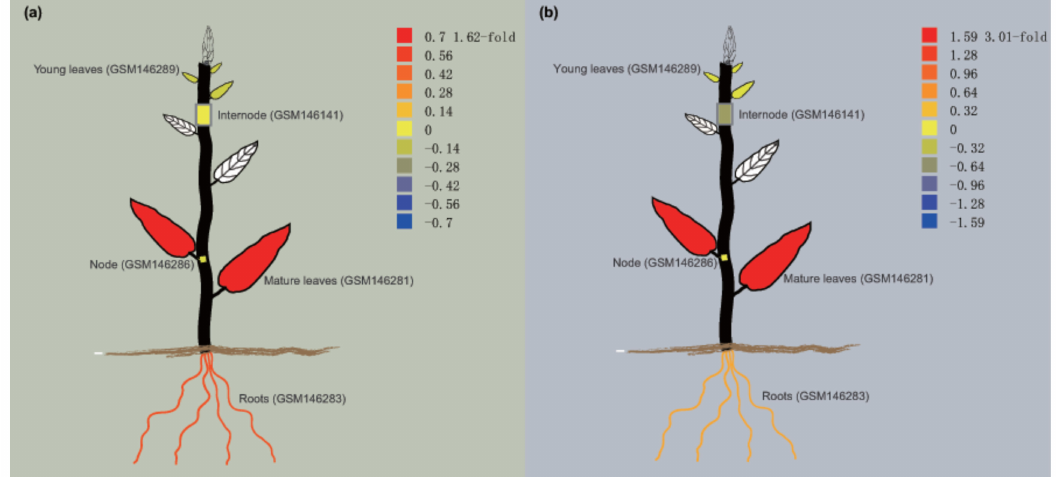
Figure 9. Tissue-specific expression pattern of PtNAC024 and PtNAC182 of Populus in silico. ( a ) Expression pattern of PtNAC024 . ( b ) Expression pattern of PtNAC182 . The related data were directly downloaded using the accession numbers of genes from PopGenIE and detected using the exImage tool of the PopGenIE V3 database (http: // popgenie.org / ). Blue indicates low expression and red denotes high